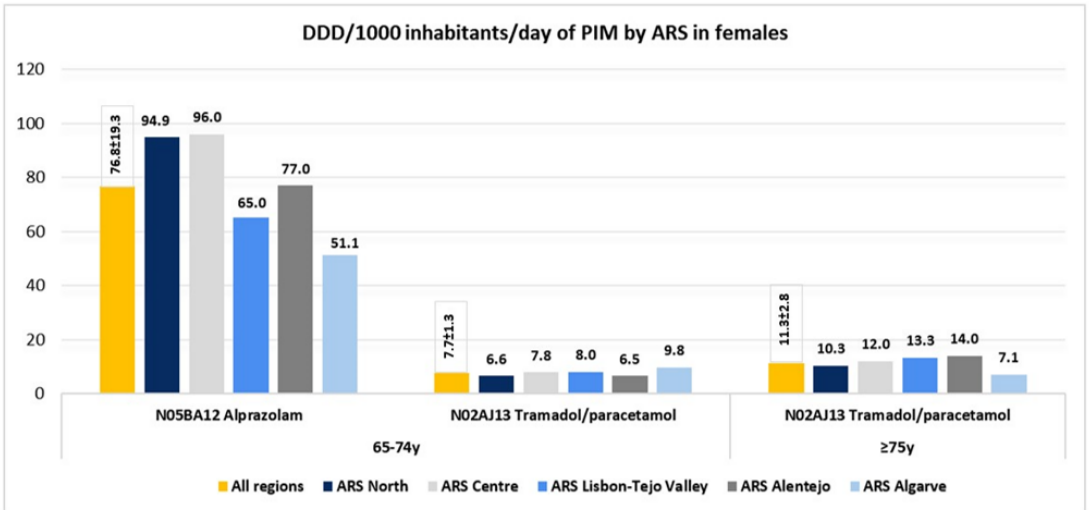
Figure 4. Defined daily dose (DDD) per 1000 inhabitants per day of potentially inappropriate medication (PIM), by health administrative region (ARS). Legend: ARS — North (ARSN), Centre medication (PIM), by health administrative region (ARS). Legend: ARS—North (ARSN), Centre (ARSC), Lisbon-Tejo Valley (ARSLVT), Alentejo (ARSALE), Algarve (ARSALG). (ARSC), Lisbon-Tejo Valley (ARSLVT), Alentejo (ARSALE), Algarve